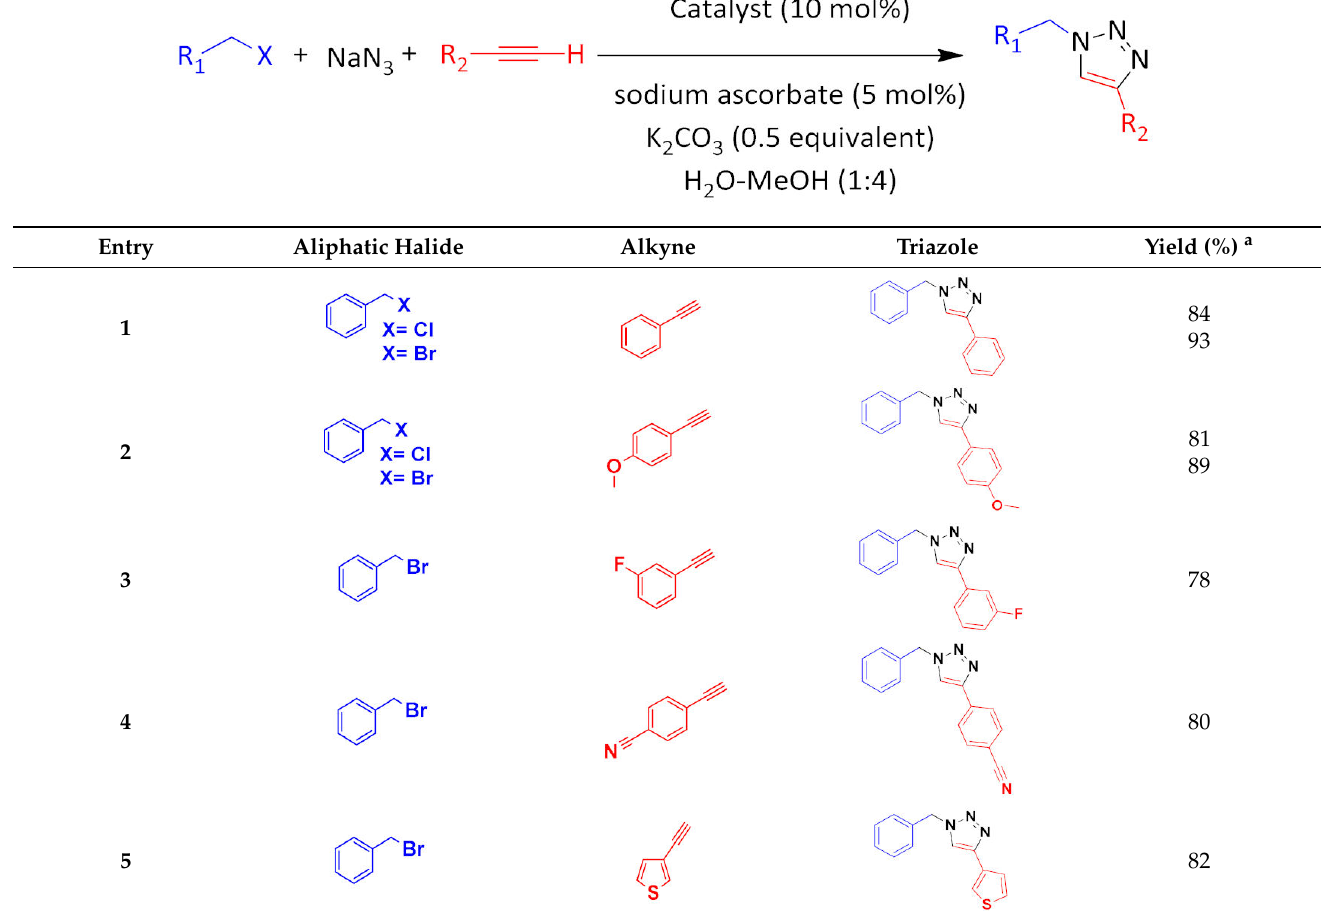
Entry Aliphatic Halide Alkyne Triazole Yield (%)